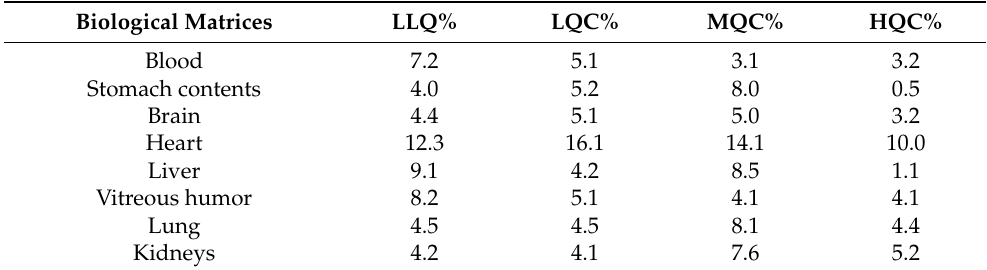
Table 5. Precision in each matrix for aldicarb–sulfone was evaluated by means of the coefficient of variation (CV%) of the lower limit of quantification (LLQ), low-quality control (LQC), medium-quality control (MQC), and high-quality control